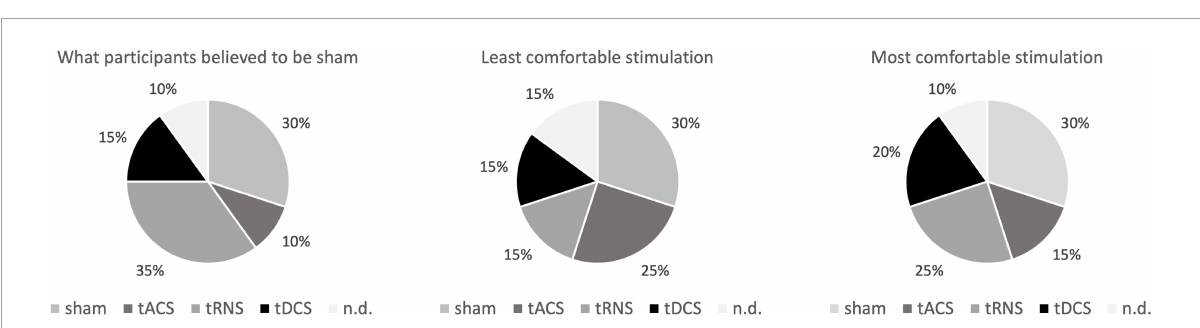
FIGURE5 Post measurement questionnaire. Shown are the data of the subjects who were asked to rate which stimulation they thought do be sham and which they found most unpleasant or pleasant. In addition to the 4 interventions, the selection “I cannot decide” was possible. There was no difference between the methods regarding those parameters. tACS, transcranial alternating current stimulation; tDCS, transcranial direct current stimulation; tRNS, transcranial random noise stimulation; n.d., no decision, e.g., “I cannot